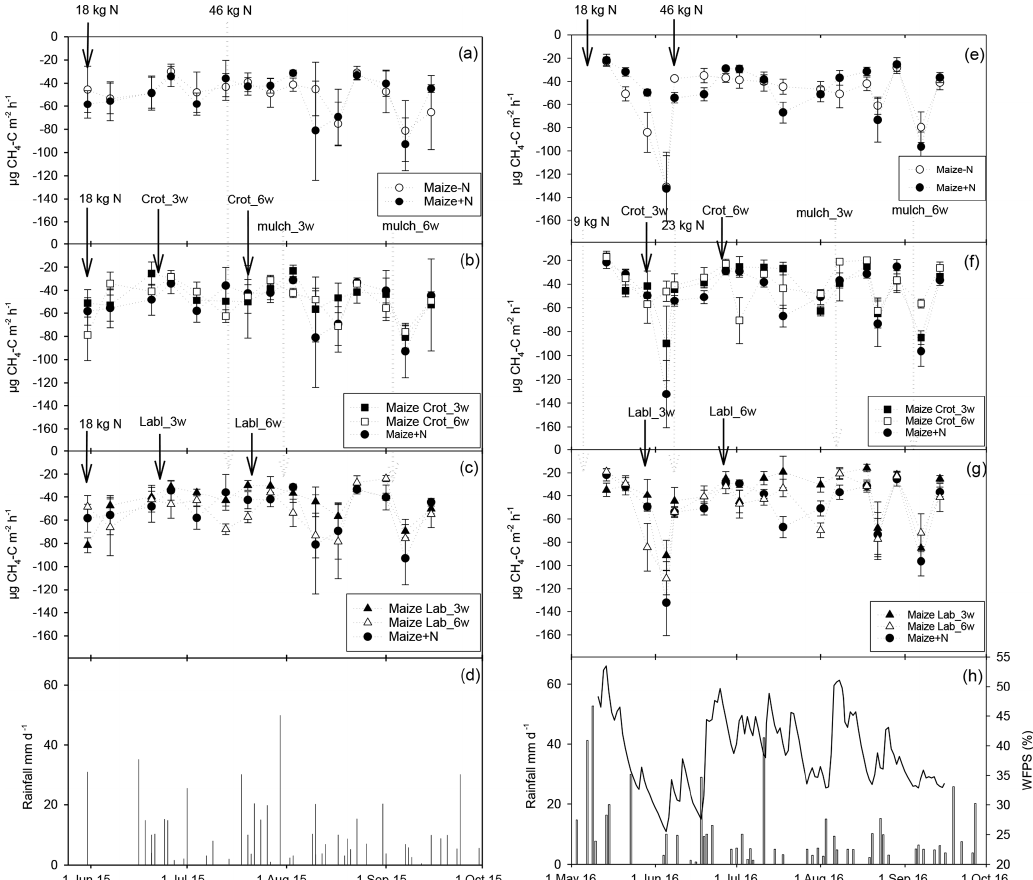
Figure 4. Mean CH 4 flux in 2015 (left column) and 2016 (right column), with daily rainfall and water-filled pore space (in 2016 only). Error bars show the standard error of the mean ( n = 4). Panels (a) and (e) show emission rates in the absence of intercrops, panels (b) and (f) with Crotalaria , and panels (c) and (g) with lablab